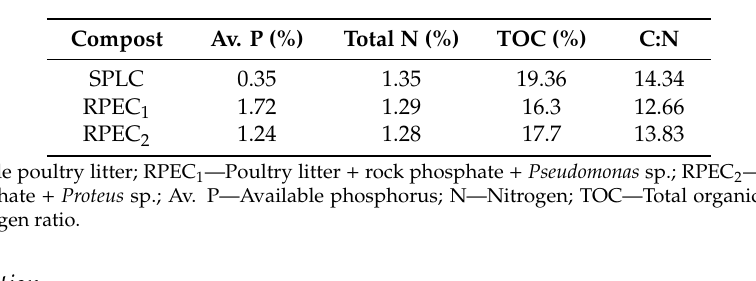
Table 2. Nutrient composition of di ff erent composts applied as treatments in the